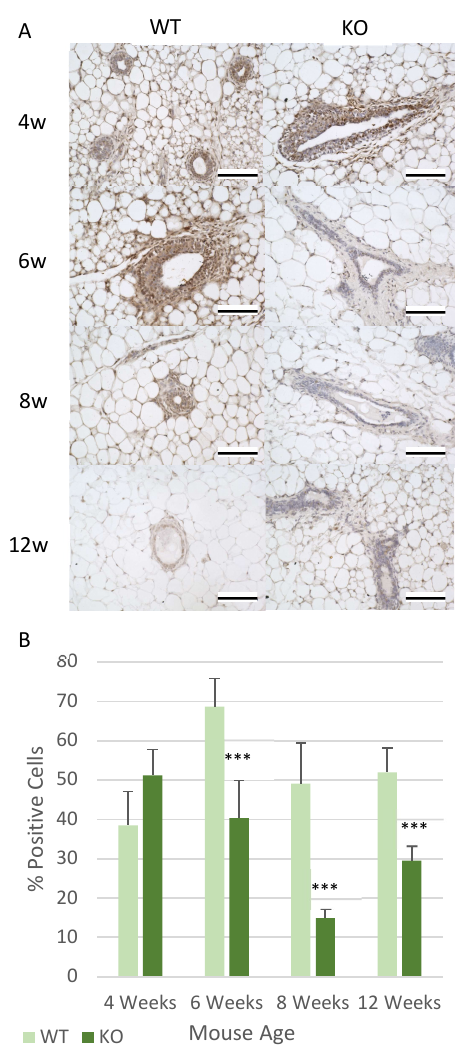
Figure 5. Changes in Stat1 expression are generated by Csmd1 KO. ( A ) Images showing the expression of Stat1 within the mammary glands ducts at all time points in both the WT and KO mice, stained using IHC ( B ) Graph highlighting the average percentage of cells positively expressing Stat1 between the WT and KO ducts by counting the percentage of positive cells per duct (*** p < 0.001). The numbers of animals for each time point included ( n = 6 WT; n = 6 KO), 6-week-old mice ( n = 8 WT; n = 7 KO), 8-week-old mice ( n = 7 WT; n = 7 KO), 12-week-old mice ( n = 7 WT; n = 7 KO). All images were taken using an x40 objective, with all scale bars 100 µ